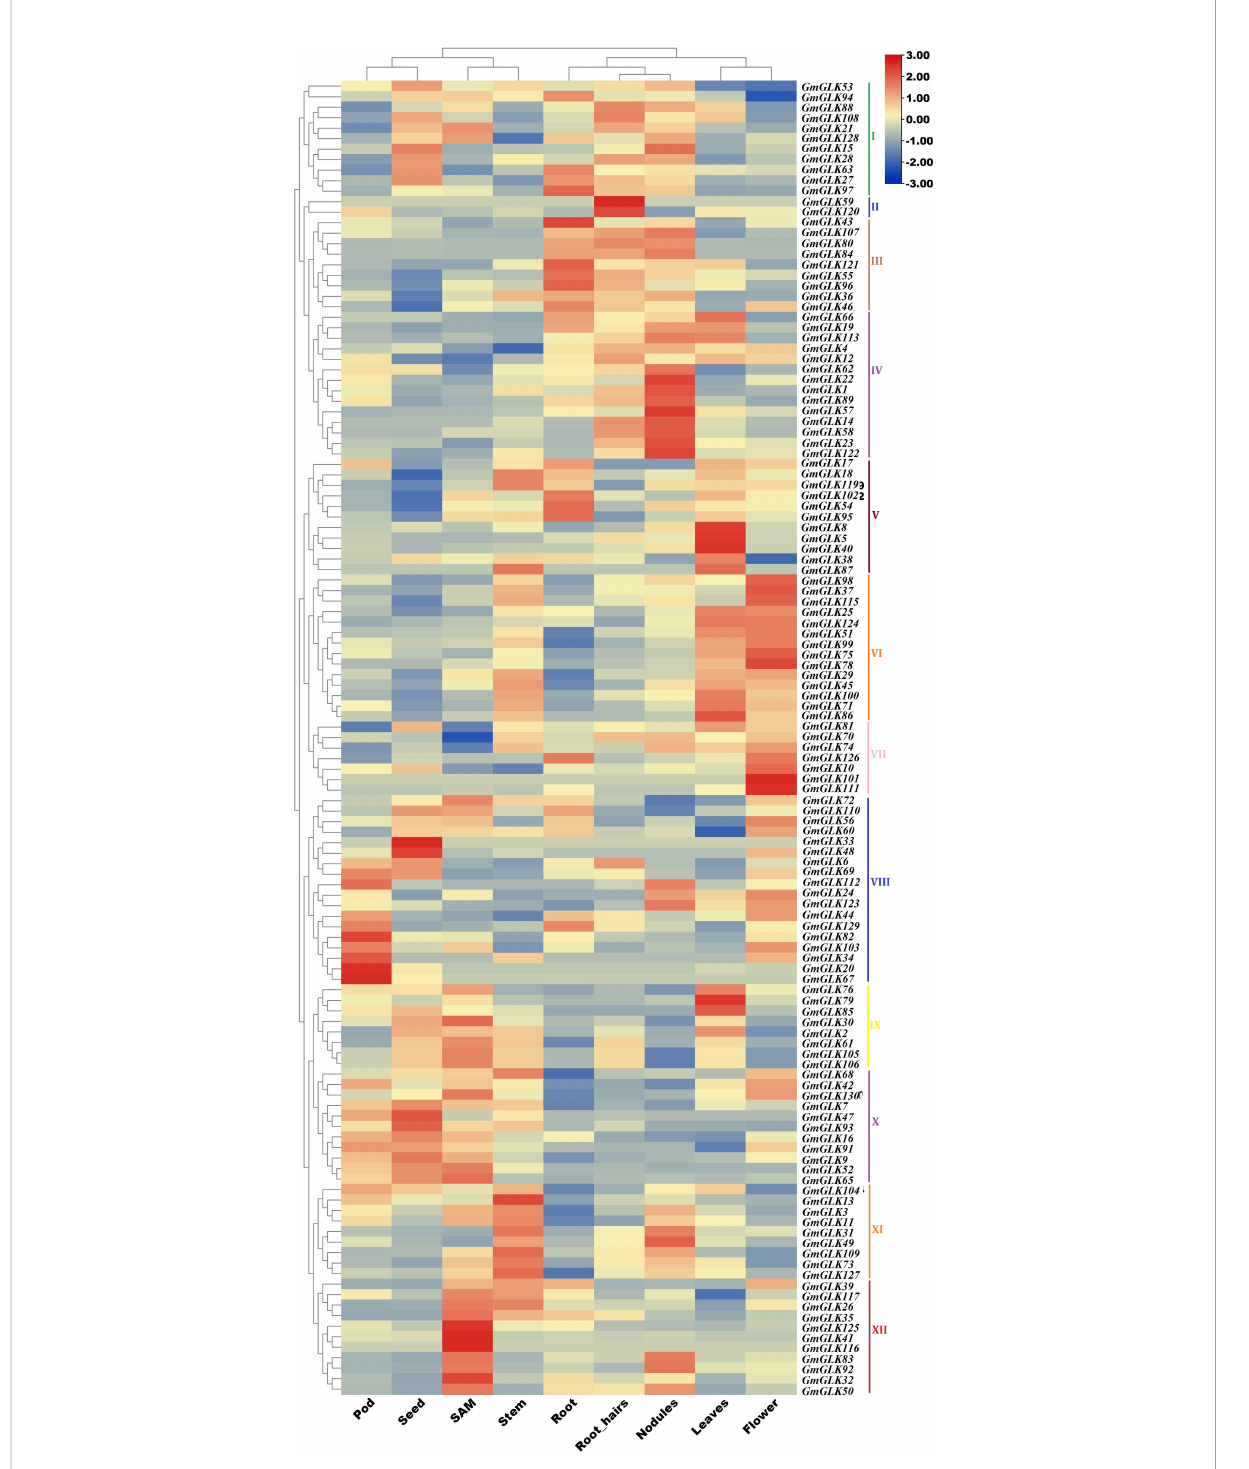
FIGURE 5 The expression pattern of soybean GLK members in various tissues/organs. The Phytozome database V12.1 was utilized to retrieve the expression data of GmGLK genes across numerous tissues. The relative bar level is on the top, and the types of tissue or organ are named on the bottom. The names of the GmGLK genes are present on the right side of the